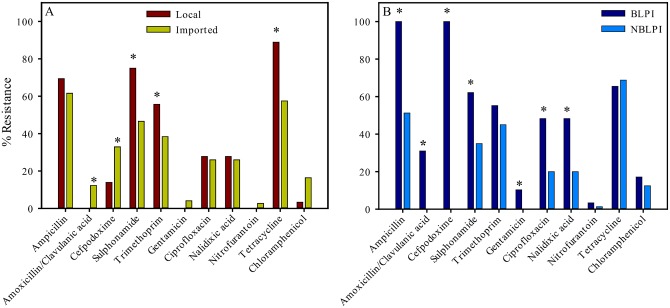
Antimicrobial resistance profile of E. coli meat isolates.A: Red bars: Strains isolated from local chickens (n = 36); Green bars: strains isolated from imported chickens (n = 73). B: Dark blue bars: Beta-lactamase producing isolates (n = 29). Blue bars: Non beta-lactamase producing isolates (n = 80). * indicates statistical significance (p < 0.05).